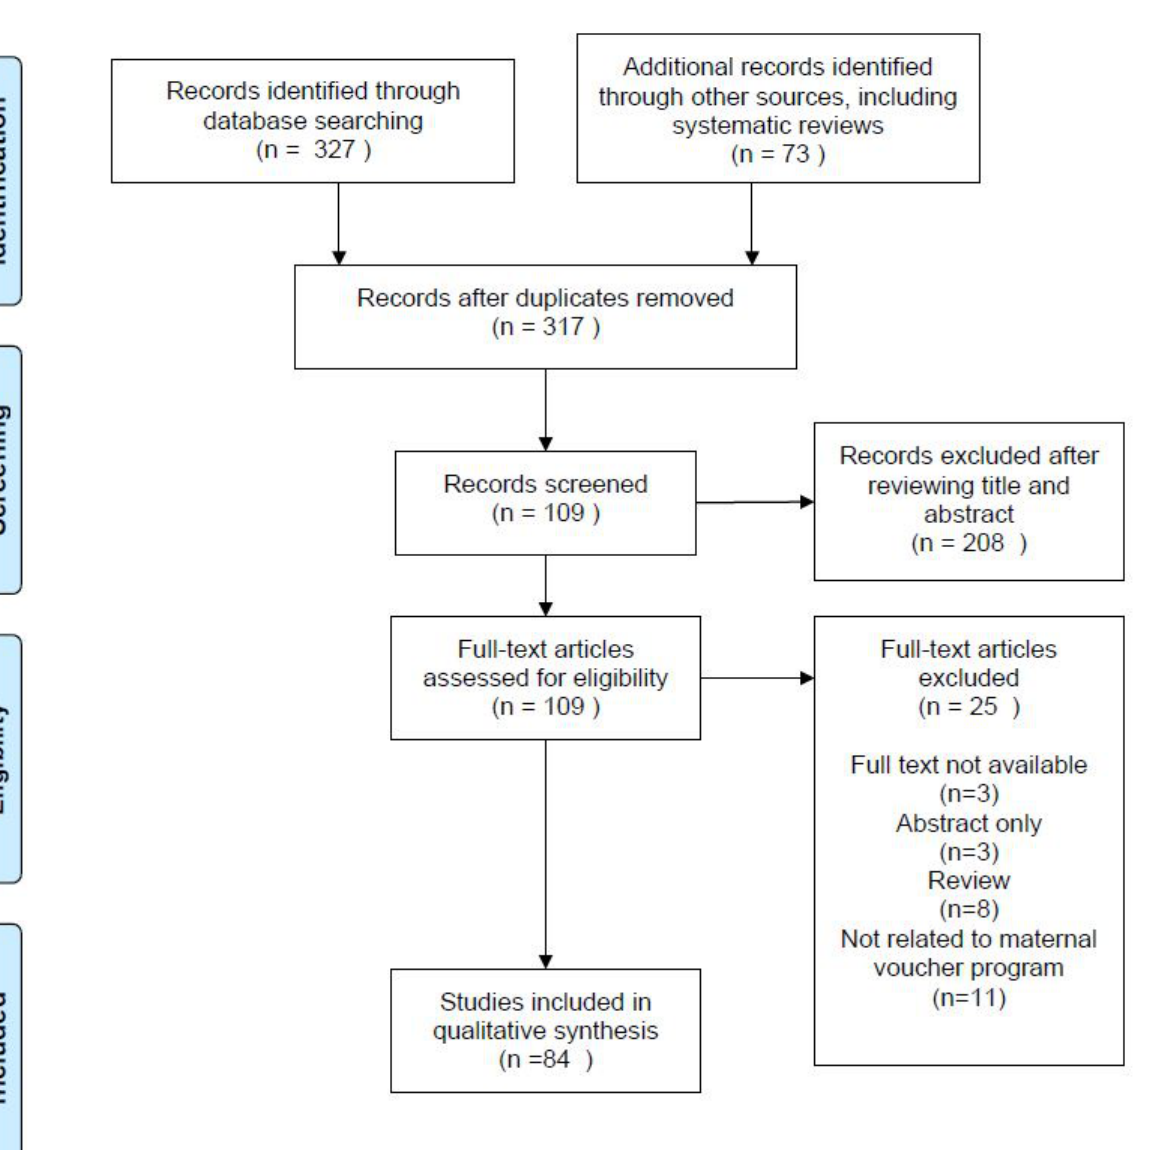
Figure 1. Flow diagram for selection process following the Preferred Reporting Items for Systematic Reviews and Meta-Analyses (PRISMA)